Question: How would you classify this visualization?
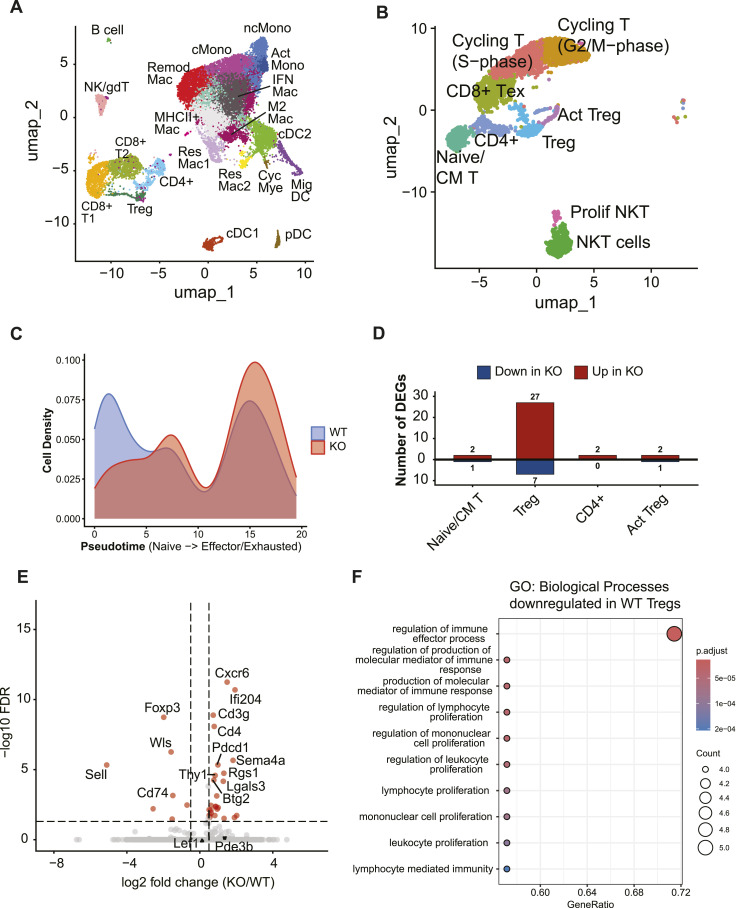
Answer: scatter